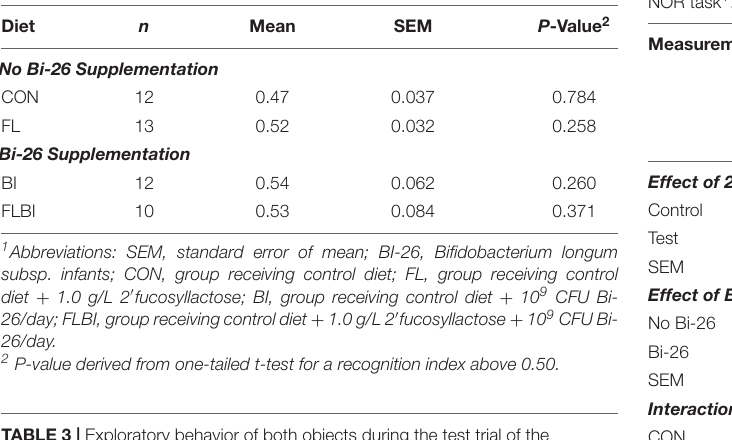
TABLE 2 | Recognition memory on the NOR task with a 48-h delay 1 . TABLE 4 | Exploratory behavior of the novel object during the test trial of the